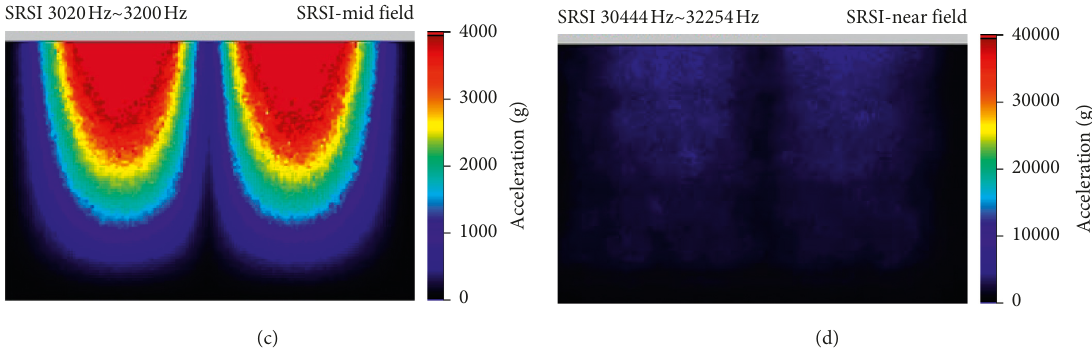
Figure 10: 1/2-inch pyrolock-induced shock propagation evaluation on the open-box-type tension joint: (a) PWPI at 300 μ s, (b) SRSI at 1kHz, (c) SRSI at 3kHz, and (d) SRSI at 30kHz.